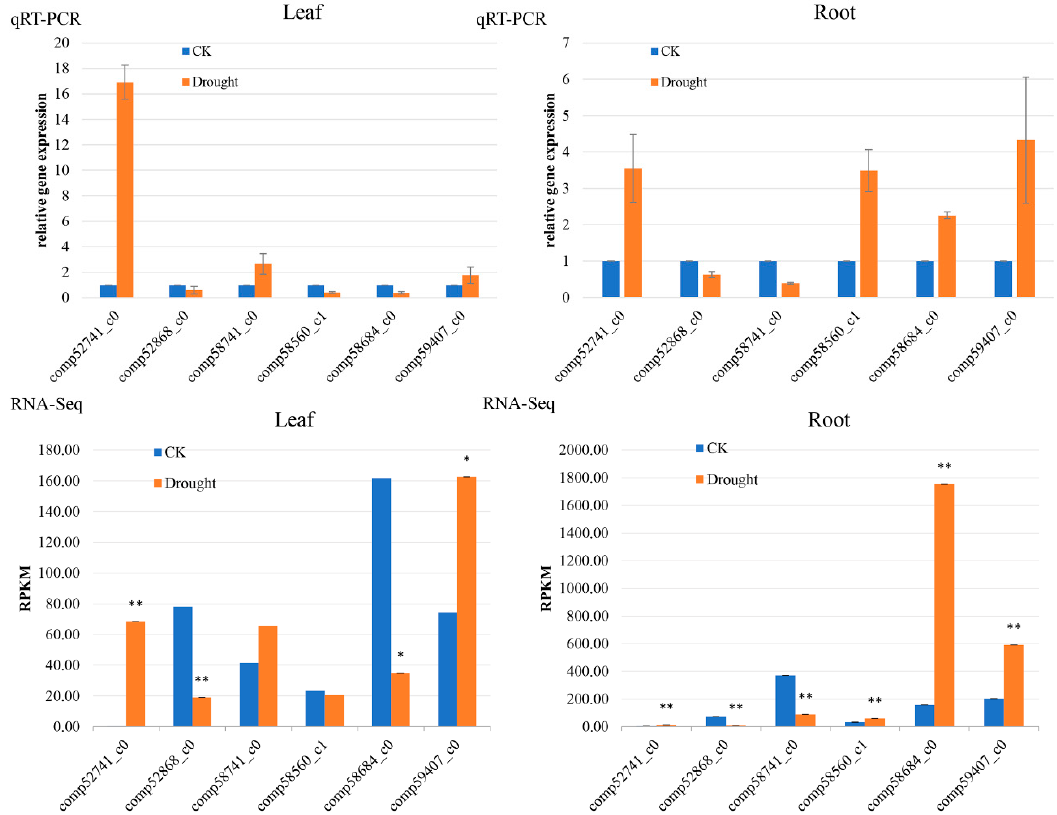
Figure 2. qRT-PCR verification of RNA-Seq analysis of gene expression. Blue columns stand for control treatment, and orange columns stand for drought treatment. qRT-PCR: Quantitative real time polymerase chain reaction; CK: controlled samples; Drought: drought treated samples; RPKM: Reads Per Kilobase per Million mapped read. * p < 0.05; ** p < 0.01.